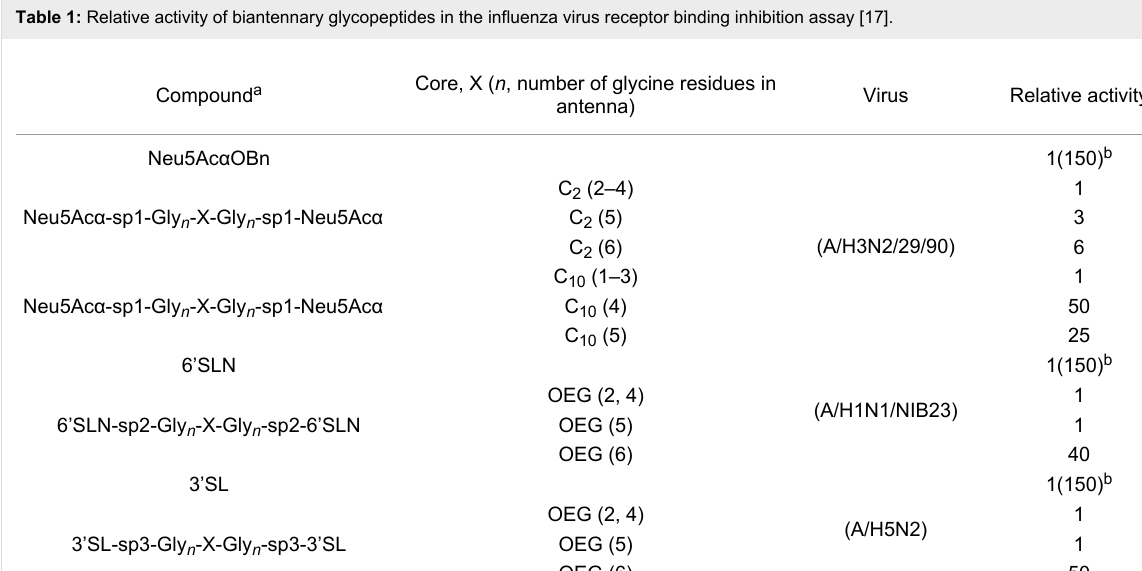
Table 1: Relative activity of biantennary glycopeptides in the influenza virus receptor binding inhibition assay [17].